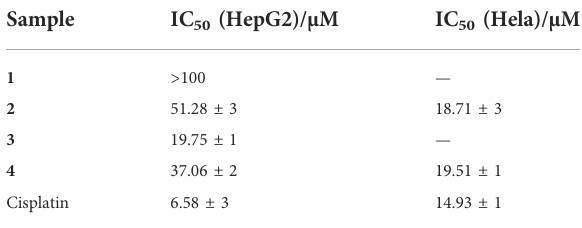
TABLE 5 Cytotoxic (IC 50 in μ M) Activities of Compounds 1 – 4 a .